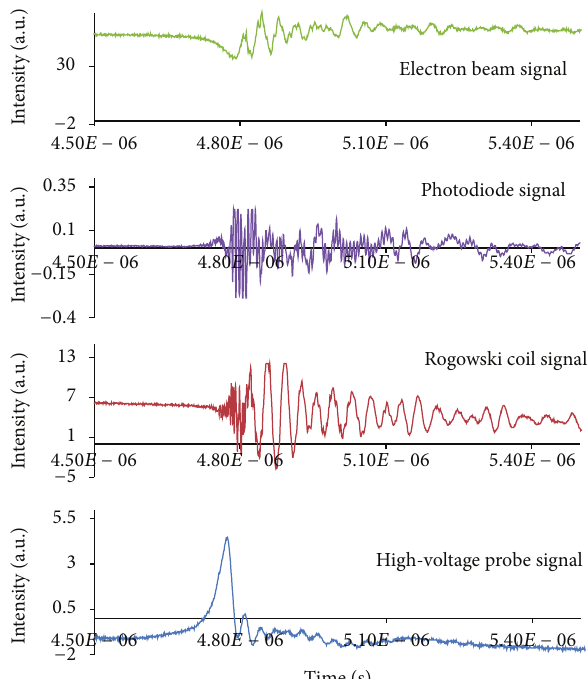
Figure 10: Typical energetic electron beam signal with the signals of photodiode, high-voltage probe, and Rogowski coil (at pressure of 1.7 mbar).